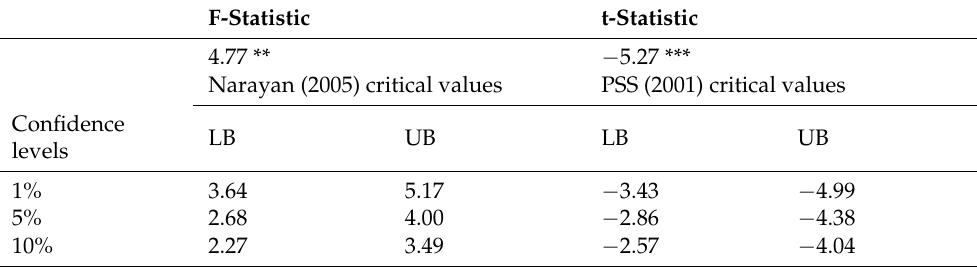
Table 5. PSS cointegration test